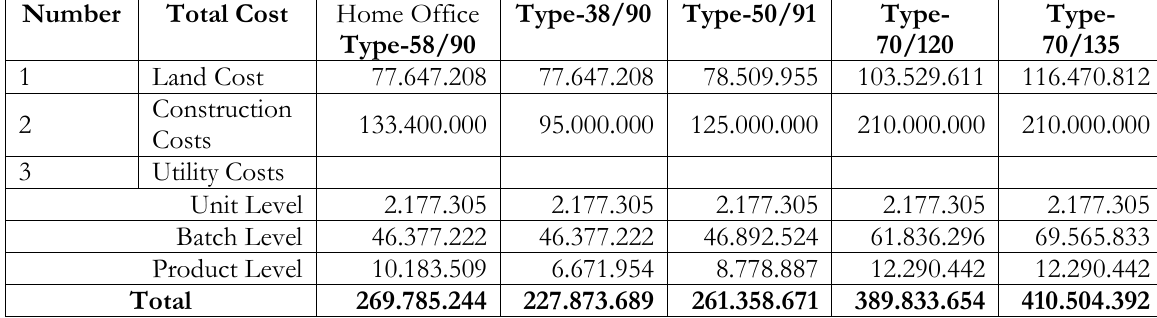
Table 9. Calculation of the Cost of Building Houses with the ABC System